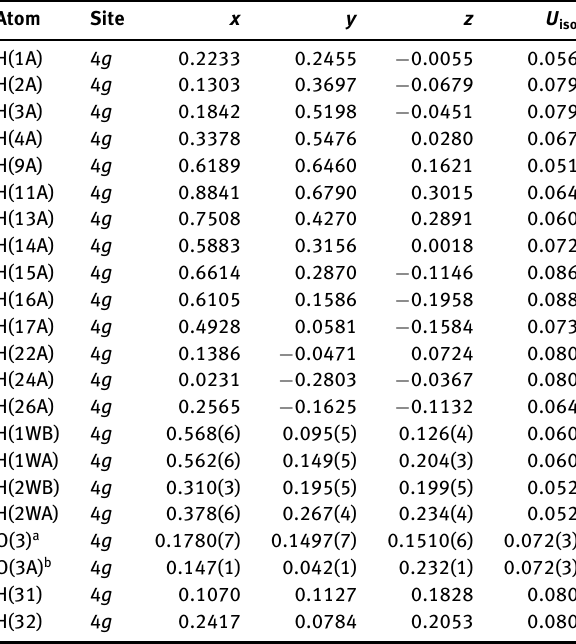
Tables 1–3 contain details of the measurement method and a list of the atoms including atomic coordinates and displacement